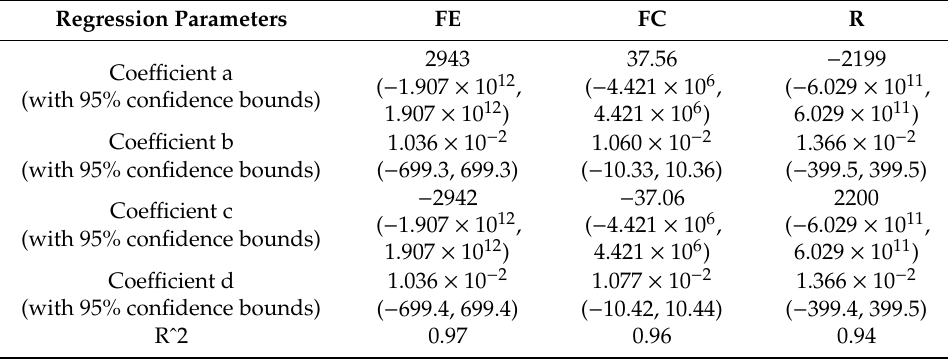
Table 7. Coe ffi cient values for the η T -s regression model (R1).